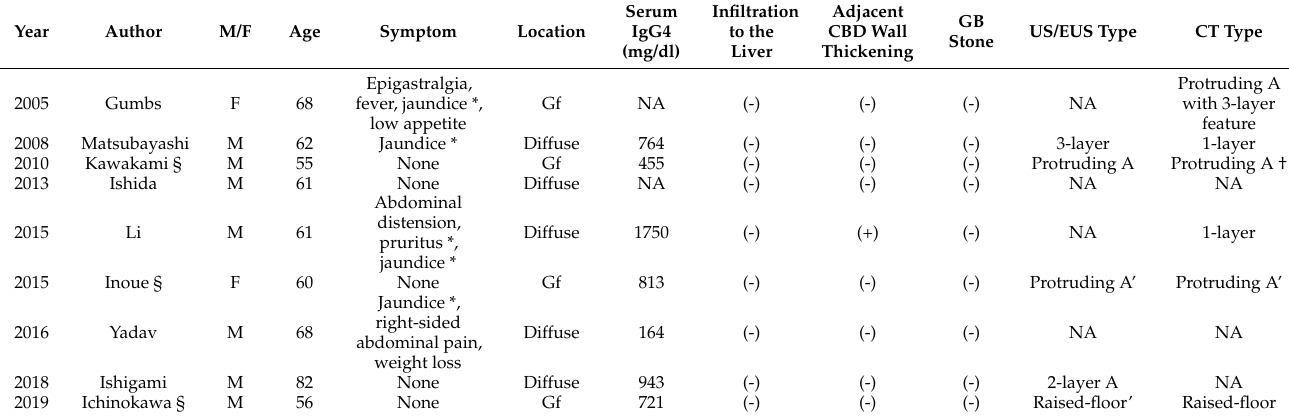
Table 1. Previous reports on IgG4-related sclerosing cholecystitis with autoimmune pancreatitis.